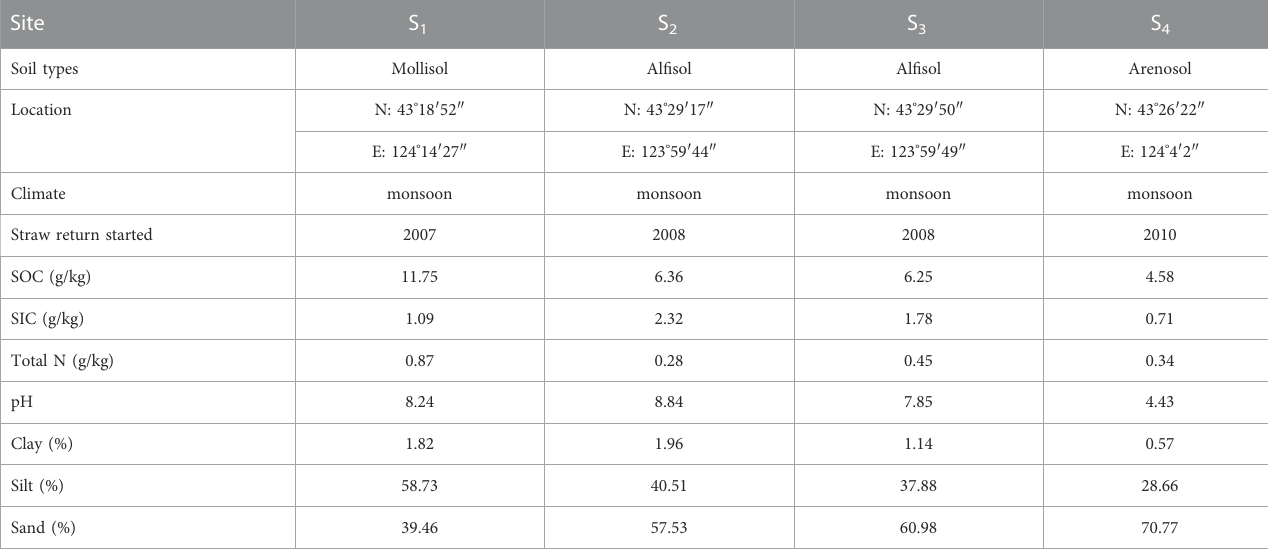
TABLE 1 Basic information of surface soil (0 – 20 cm) at each study